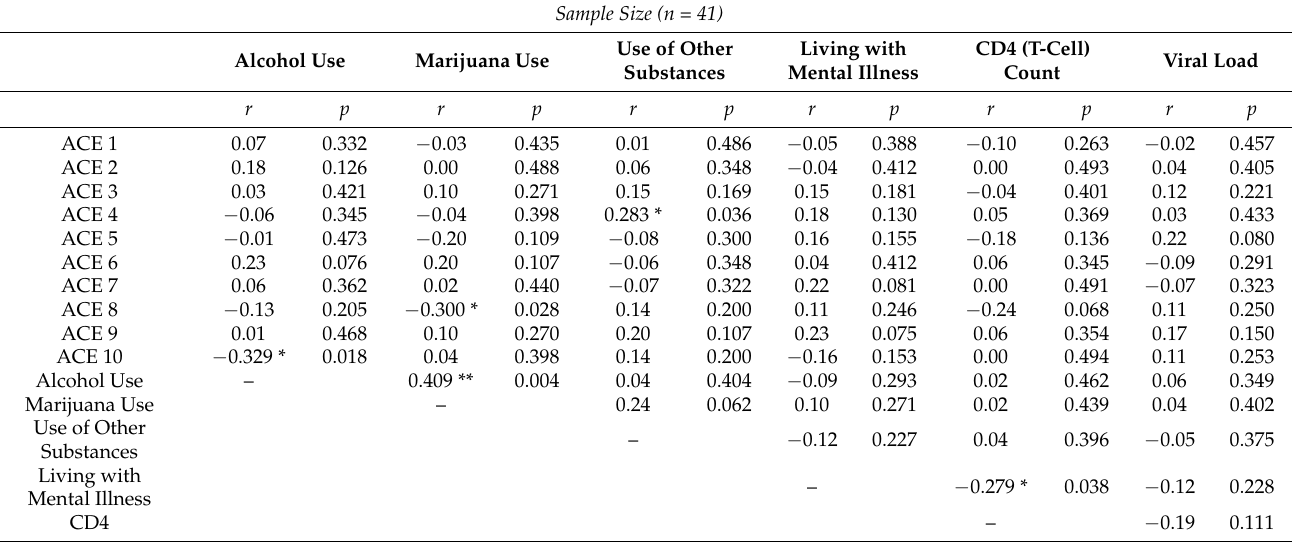
Table 4 for correlation details. Table 4. ACE item